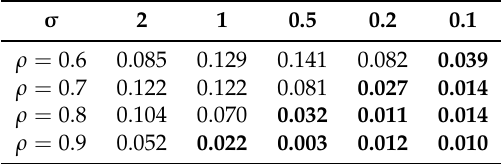
Table 2. Values of Kolmogorov distance of approximation ˆ P for various values of σ and ρ . σ 2 1 0.5